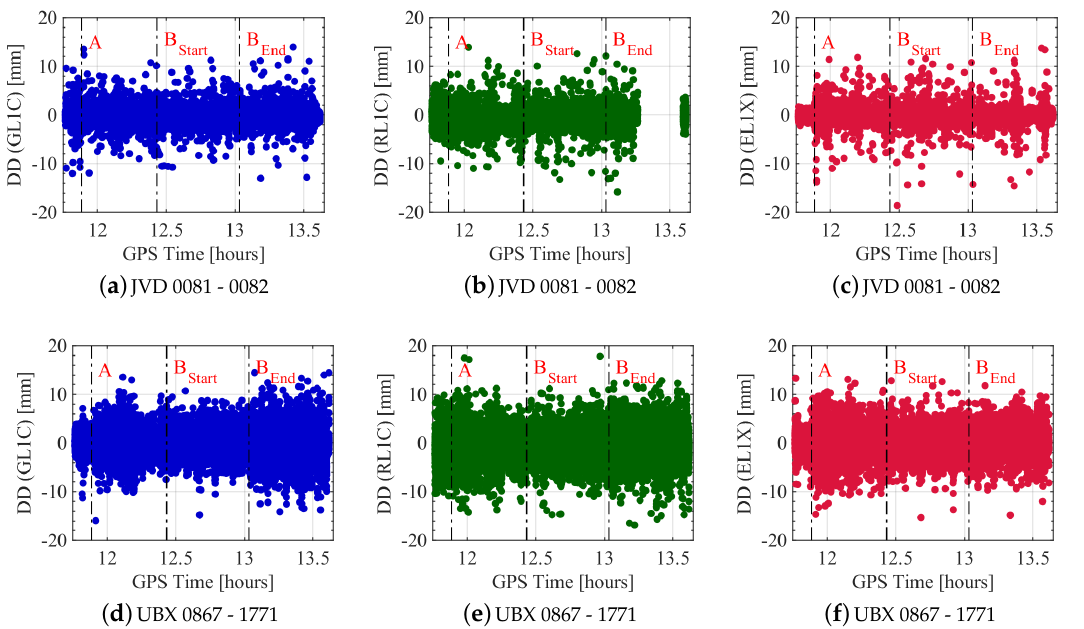
Figure 8. DDs of L1 carrier phase observations from all satellites for different receiver combinations with respect to GPS time. GPS, GLONASS and Galileo DD are shown in blue, green and red colours, respectively. Black dashed vertical lines indicate different points of the trajectory, which are explained in Table